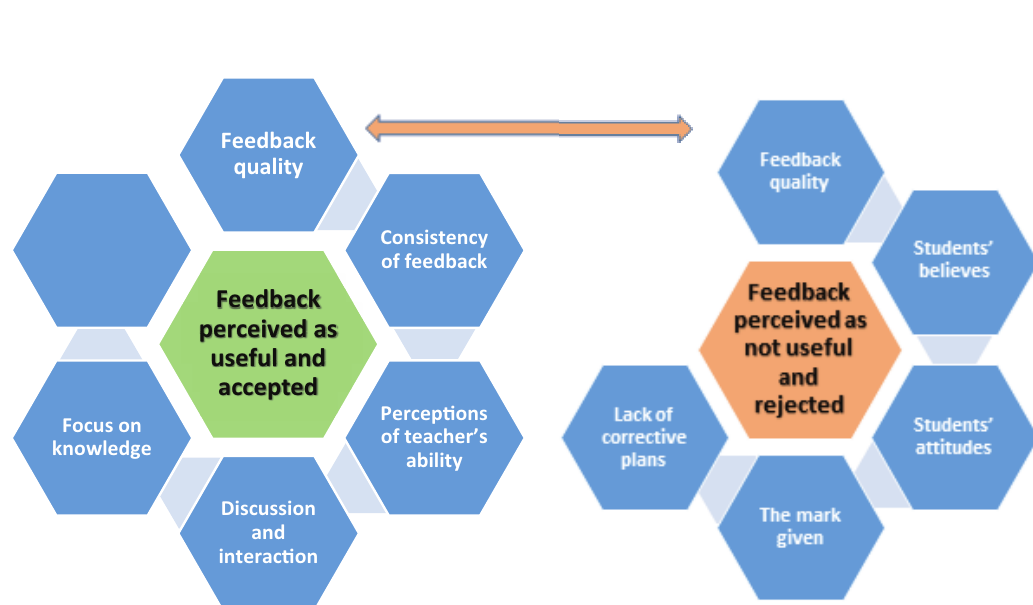
Figure 2 : Overarching themes, subthemes, and their relationship to each other regarding the perceived usefulness and acceptability of feedback ( arrow indicates a dual role for the factor